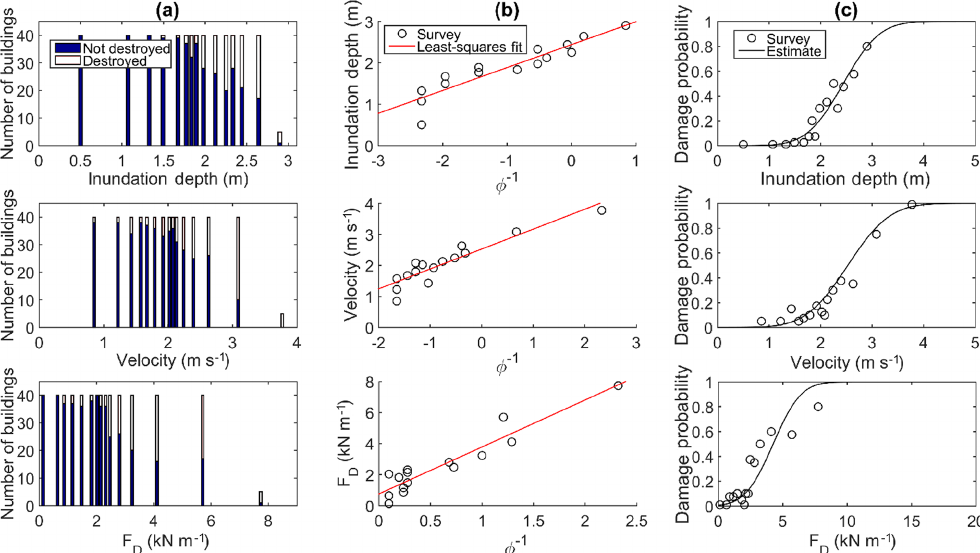
Figure 8. Developing the tsunami fragility curve. (a) Histogram of the number of destroyed and not-destroyed structures in terms of the tsunami intensity measures within the inundation area. (b) Data plotted on normal probability paper and least-square fit. (c) Fragility function for building damage in terms of the tsunami intensity measures; the solid line is the best-fit curve of the plot (circles show the distribution of damage